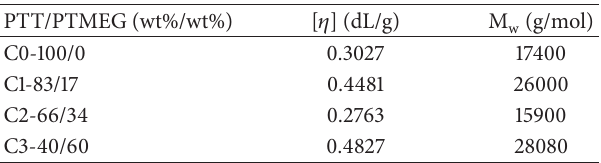
Table 1: Intrinsic viscosity and molecular weight of the various